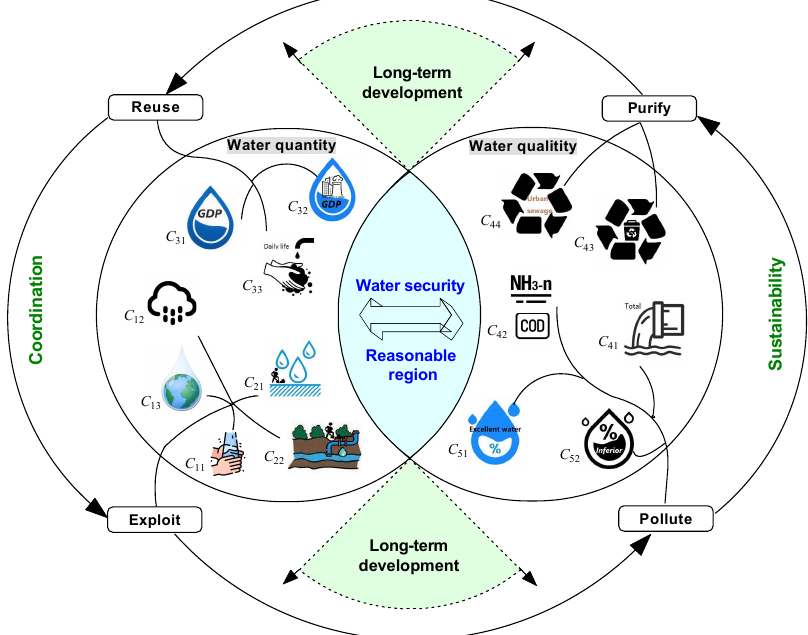
Figure 2. Regional water security evaluation